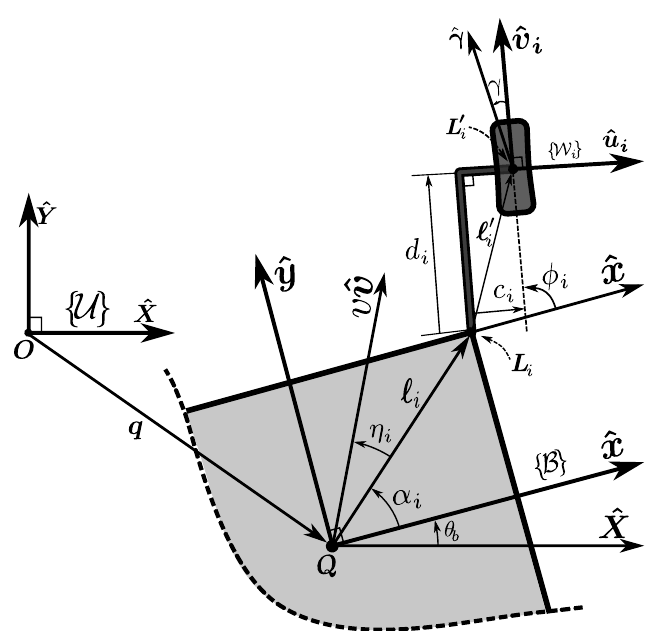
Figure 2. A generalized wheel and its corresponding